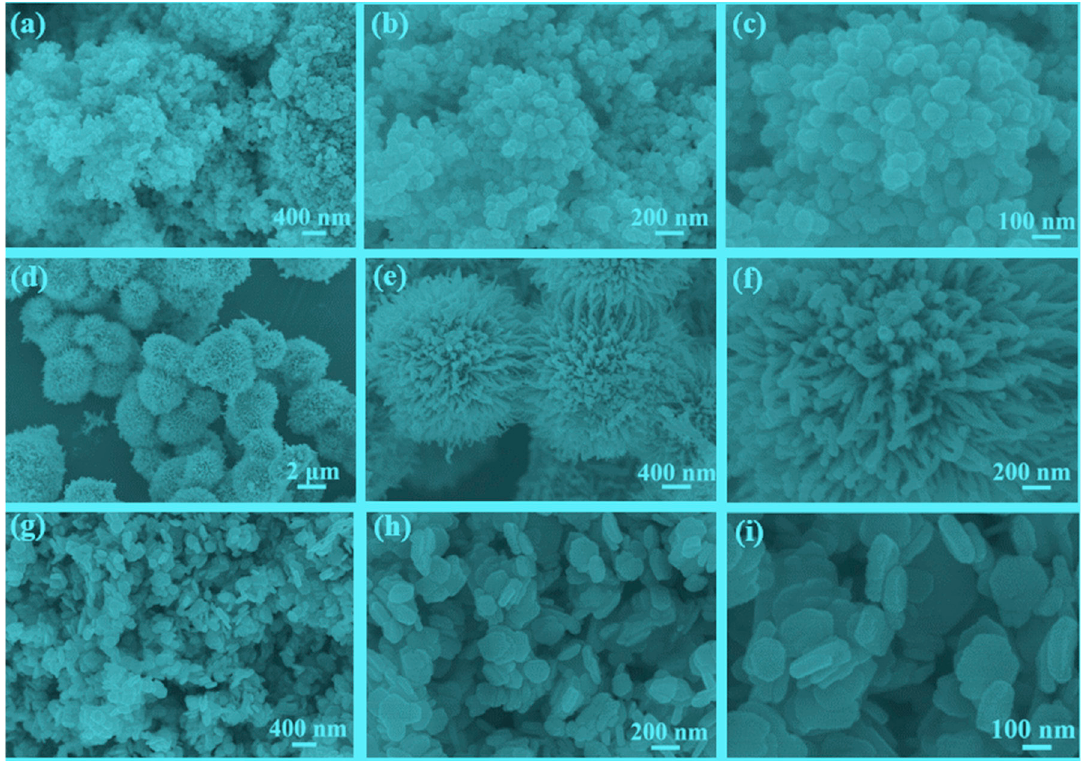
Figure 2. SEM images of the Ni 0.5 Cu 0.5 Co 2 O 4 nanoparticles ( a , b , c ), Ni 0.5 Cu 0.5 Co 2 O 4 microspheres ( d , e , f ), and Ni 0.5 Cu 0.5 Co 2 O 4 nanoplatelets ( g , h , i ).